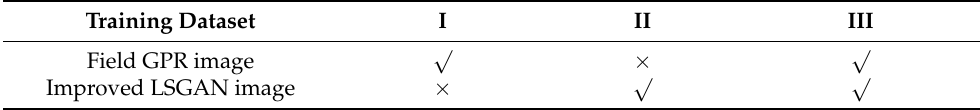
Table 4. Setup of the training GPR dataset.